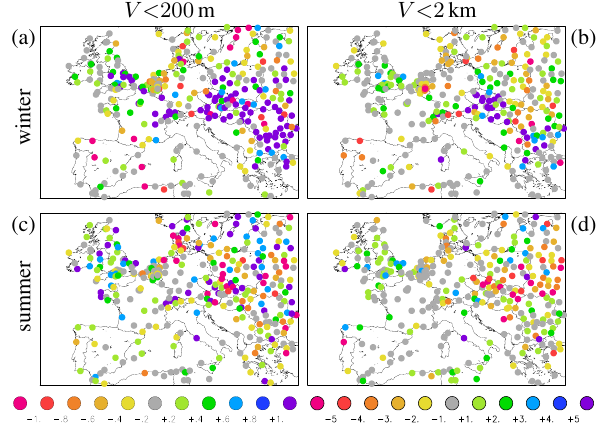
Fig. 14. As Fig. 12 but for geostrophic vorticity B (arbitrary units).